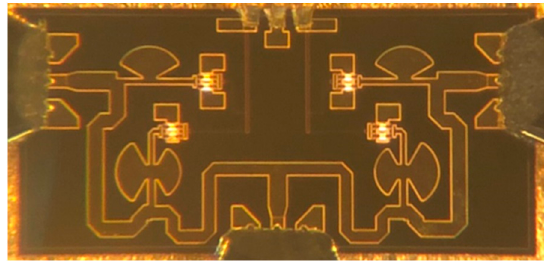
Figure 11. Chip photograph of the fabricated SPDT switch in standard 0.15- µ m pHEMT MMIC process from WIN Semiconductor.